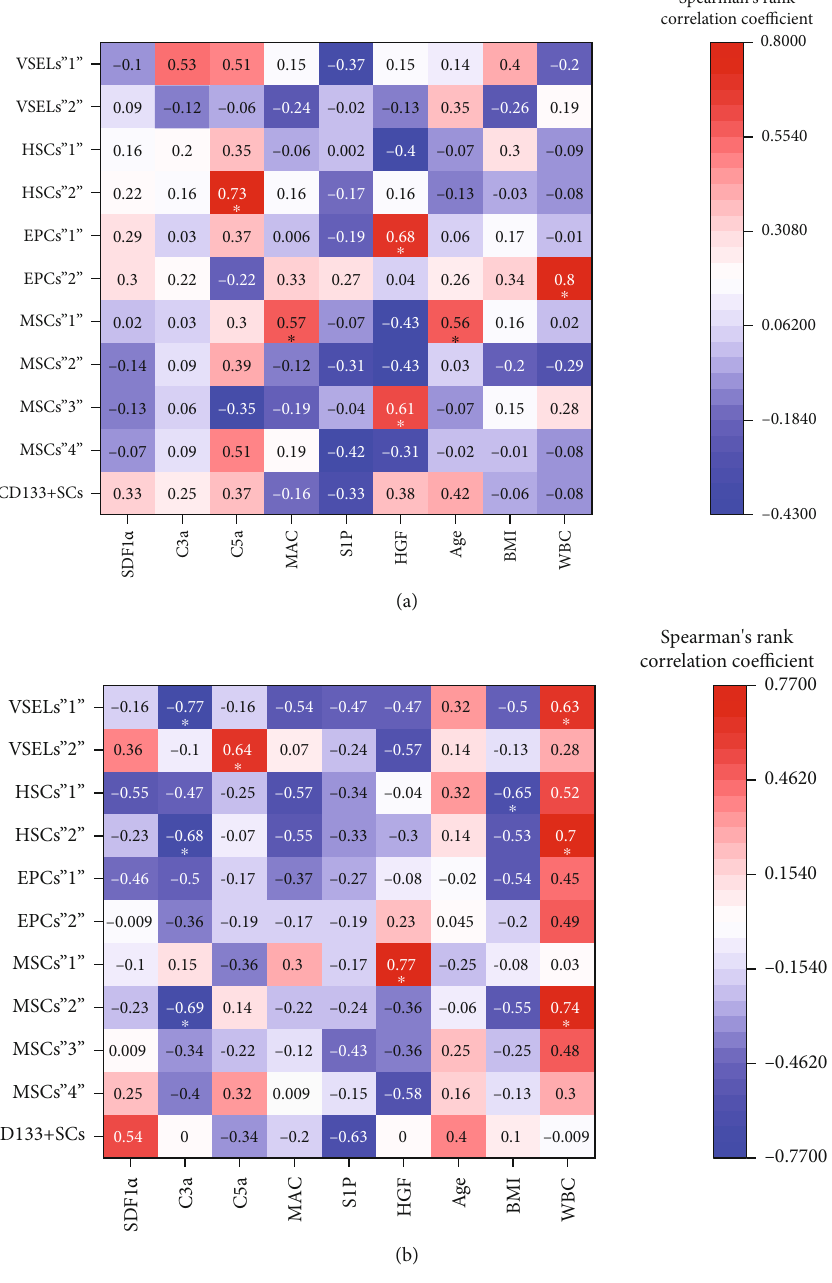
Figure 7: Heatmaps of the Spearman rank correlation coe ffi cients between circulating populations of BMSCs and the concentration of chemoattractive factors or general patient characteristics. (a) MAP patients. (b) SAP patients. ∗ P < 0 : 05